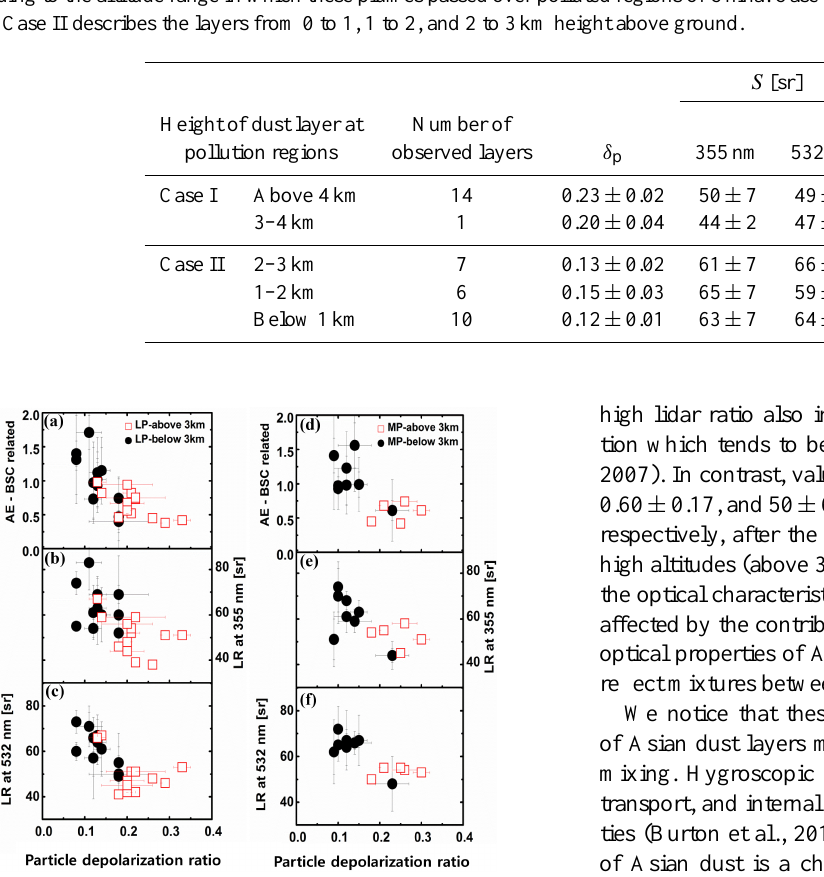
Figure 7. Scatterplot of the linear particle depolarization at 532nm versus (a, d) the backscatter-related Ångström exponent (355/532nm wavelength pair), (b, e) the lidar ratio at 355nm and (c, f) the lidar ratio at 532nm. The left column (a–c) shows the opti- cal properties of Asian dust layers considered less polluted (LP), the right column (d–f) shows the more polluted cases. The Asian dust layers that passed over polluted regions in China at low altitude are denoted by black circles. The Asian dust layers transported at high altitude are denoted by red